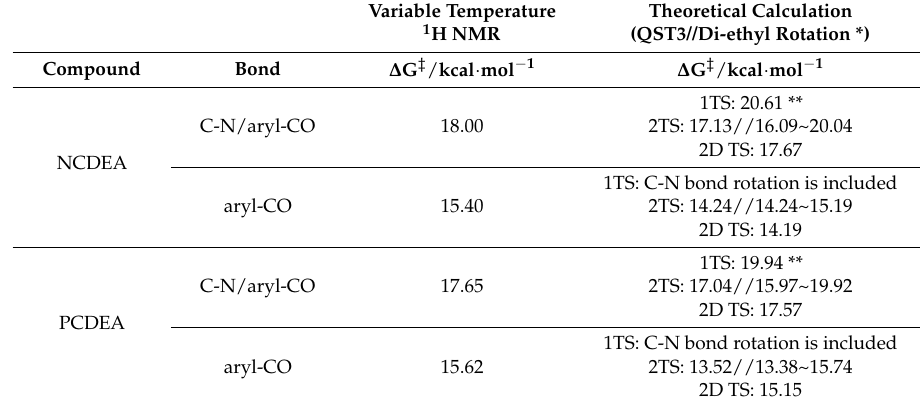
Table 3. Comparison of the relative experimental Gibbs free energy differences to computational results.